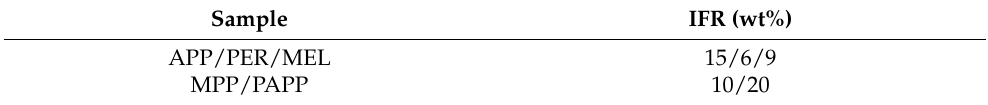
Table 1. Formulations of IFR.